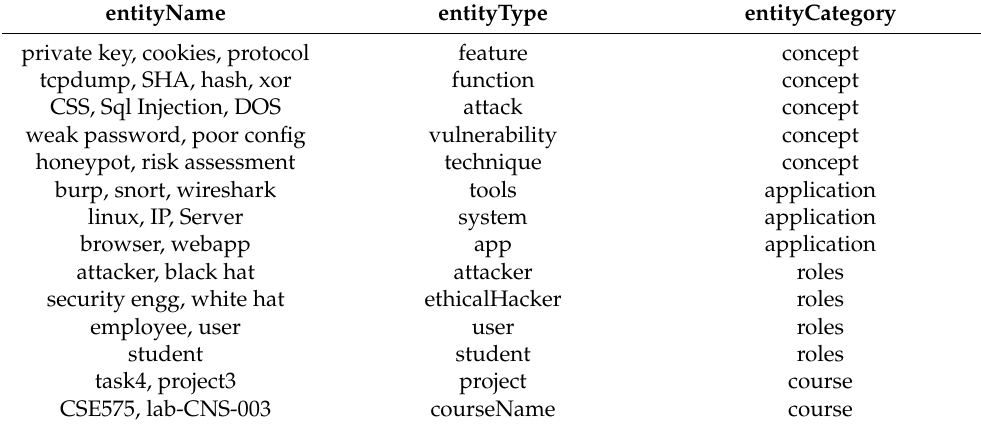
Table 1. Example of key entities identified in each category, as explained in Section 3.1.4.